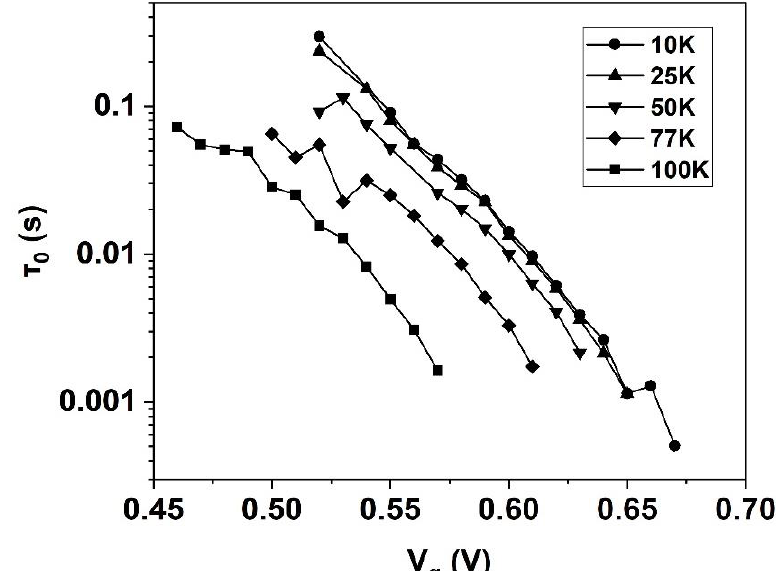
Figure 5. 𝜏 0 versus 𝑉 𝑔 at different cryogenic temperatures. Figure 5. τ 0 versus V g at different cryogenic